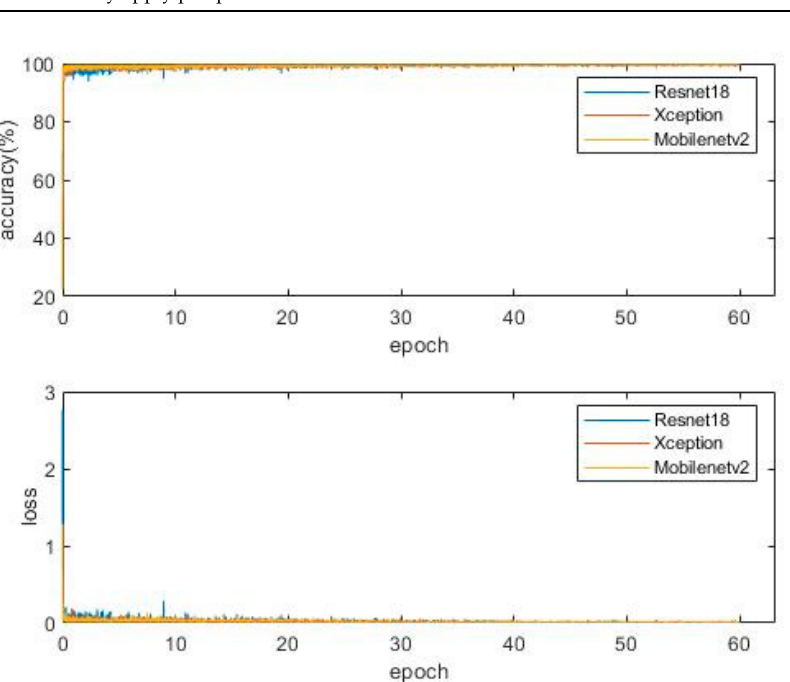
Figure 7. The loss and accuracy curve from the training process.